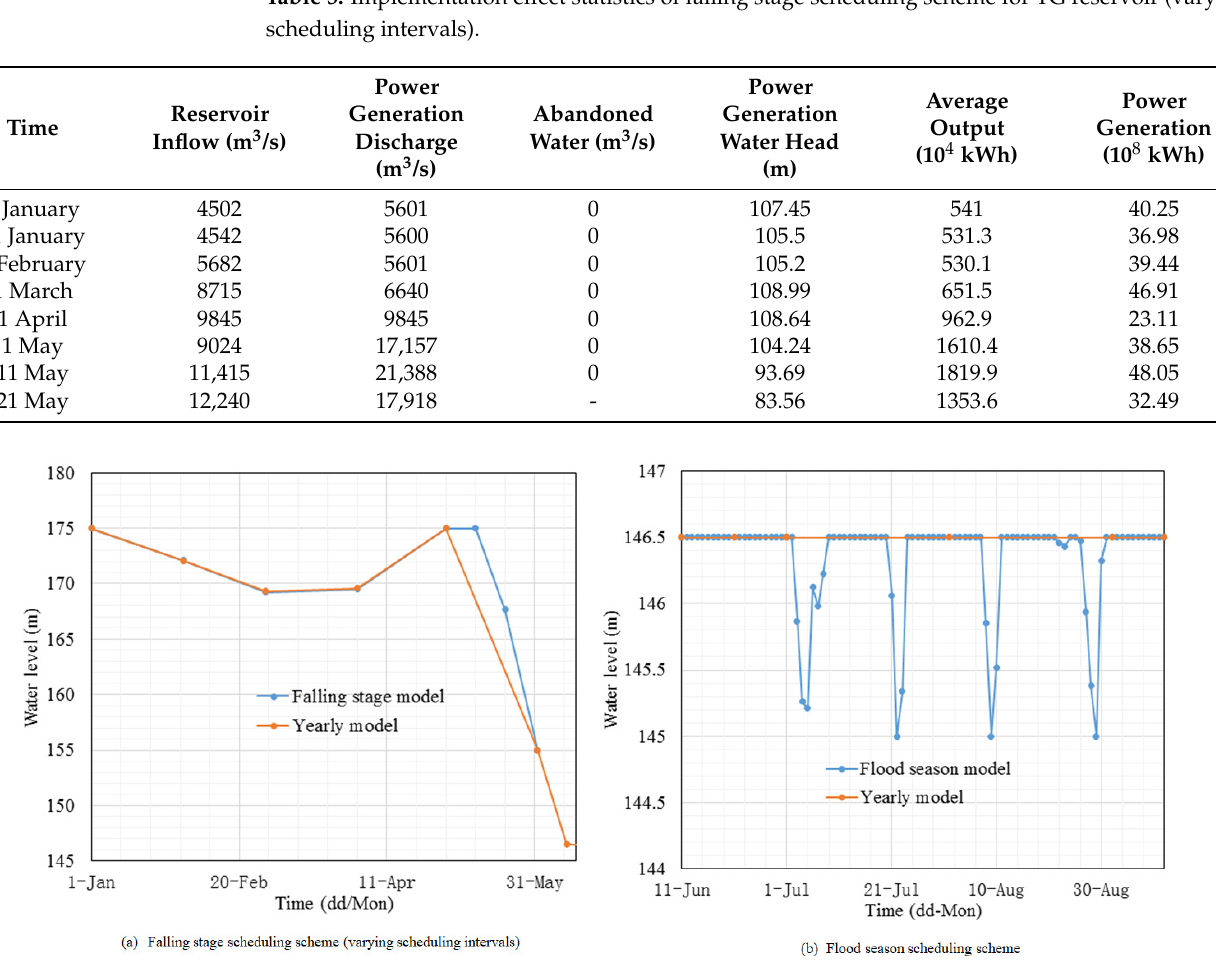
Figure 10. TG reservoir operation